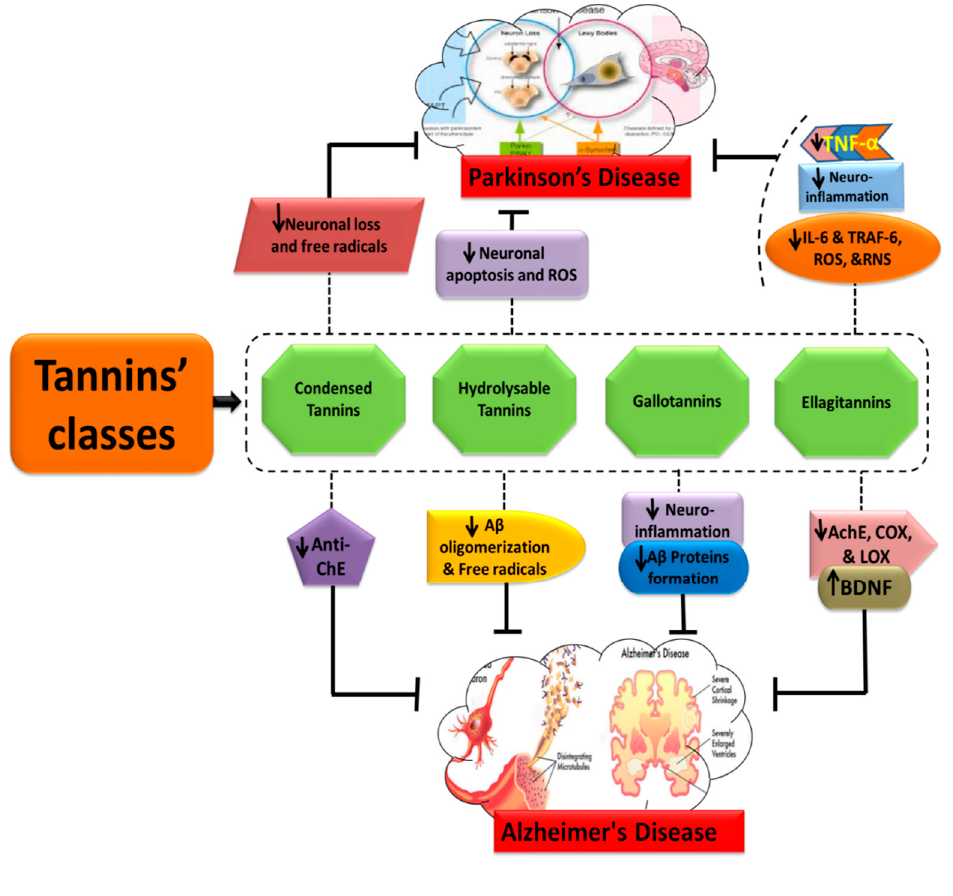
Figure 4. Neuroprotective e ff ects of tannins.